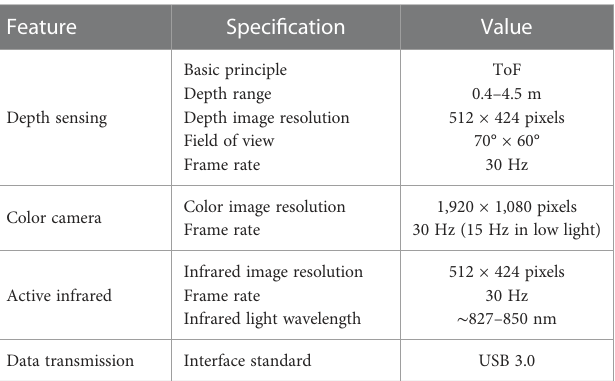
TABLE 1 General speci fi cations of Kinect